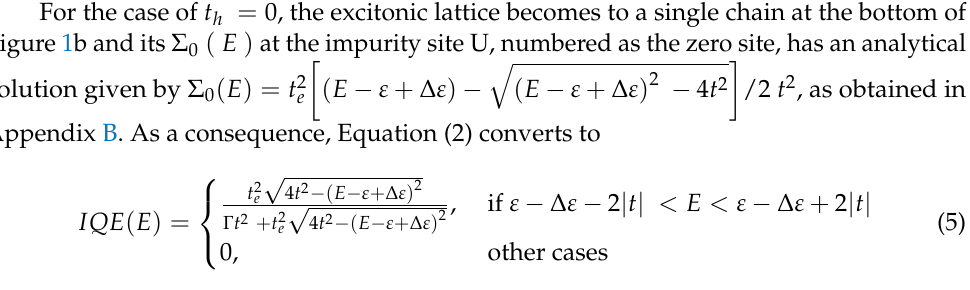
Figure 2. (Color online) Internal quantum efficiency (IQE) as a function of the driving force ( ∆ ε ) and photon energy (E) for a lattice of ( N h + 1 ) × ( N e + 1 ) = 67,108,864 × 200 excitonic states with arbitrary local Coulomb interaction U, an electron-hole recombination rate Γ = 0.01 ε and hoping integrals t = t e = t h = − 0.1 ε except in ( a ) for t h = 0 on a reduced excitonic lattice of N e + 1 = 200 states. The used non-local electron-hole interactions are ( a , b ) V = W = 0, ( c ) V = 2 W = − 0.2 ε , and ( d ) V = 2 W = − 0.4 ε